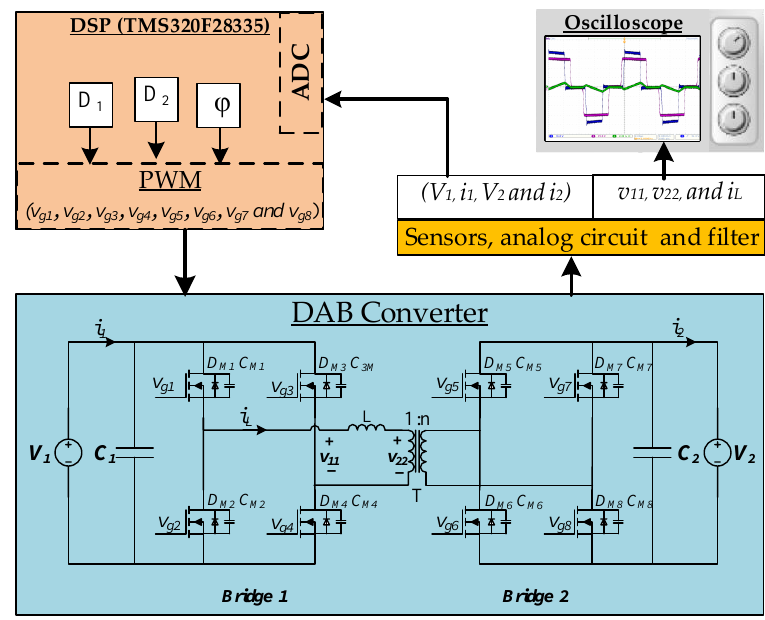
Figure 11. Block diagram of the experimental circuit layout.